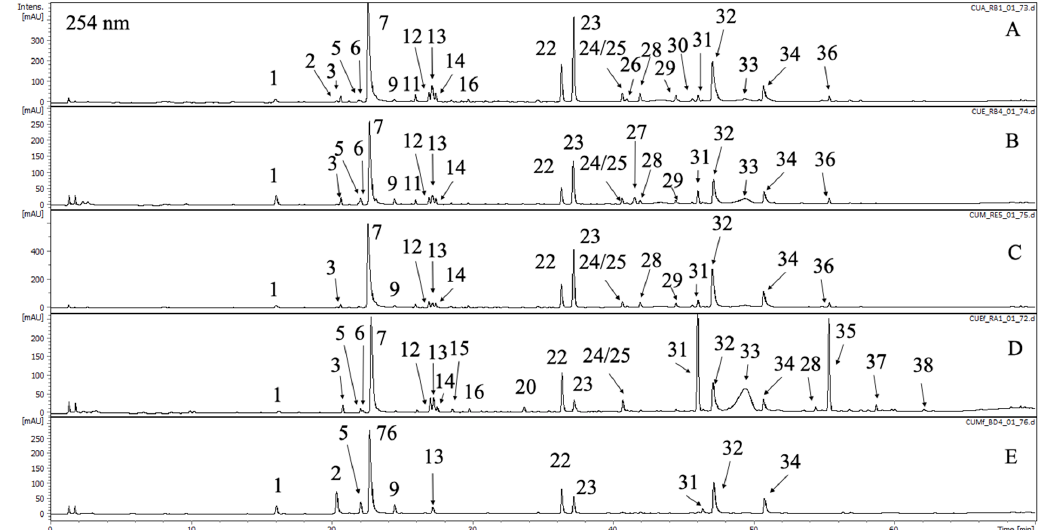
Figure 1. The LC-DAD chromatogram of C. uralensis acquired at 254 nm with marked compounds.